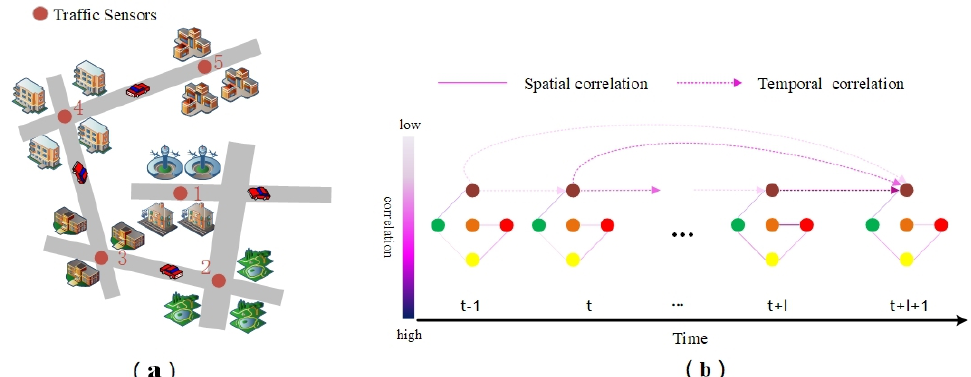
Figure 1. ( a ) Urban transport network, where the red points identified as 1 to 5 denote traffic sensors with varying periodicity of sensor time patterns at different locations. ( b ) Traffic signal tensor map from time t − 1 to t + l + 1, where the traffic flow at the current time step of a node is correlated not only with the previous time step, but also with all historical traffic